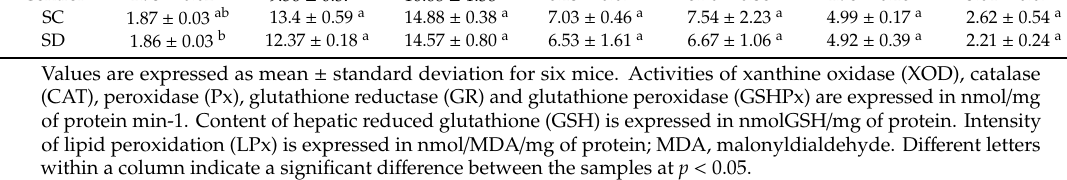
Table 3. BiochemicalparametersofcontrolgroupandthegroupstreatedwiththeSD1andSC1extracts[36]. Group XOD CAT Px GR GSH-Px GSH LPx Control 1.93 ± 0.02 a 9.56 ± 0.37